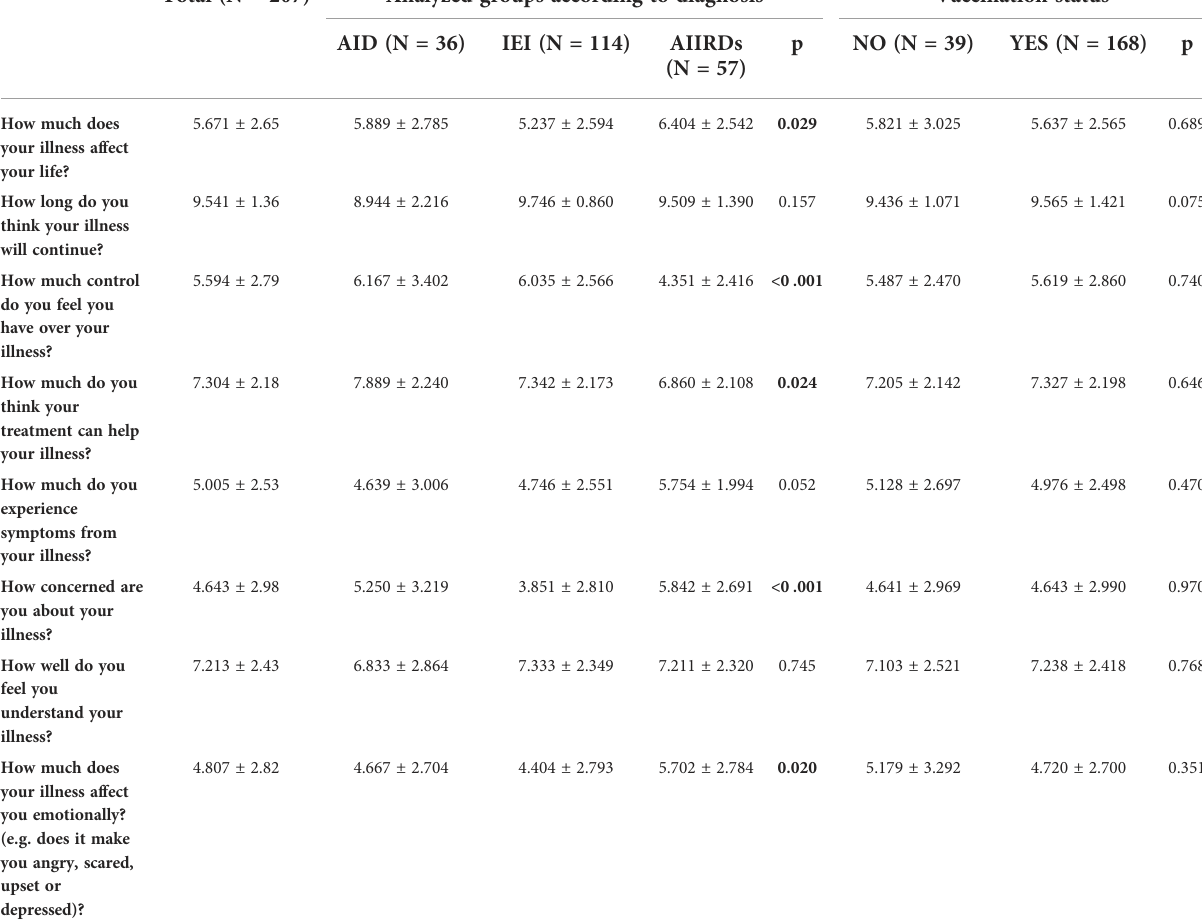
TABLE 3 Brief Illness Perception Questionnaire result comparisons among the study